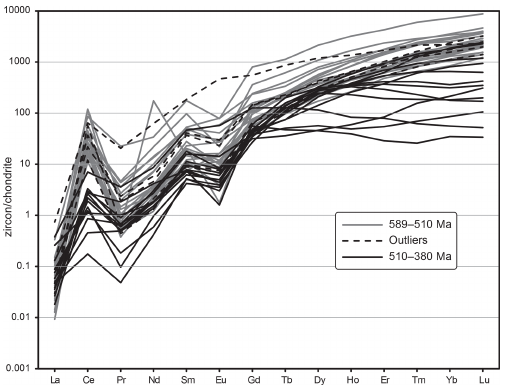
Figure 12. Chondrite-normalized plots for zircon between 589 and